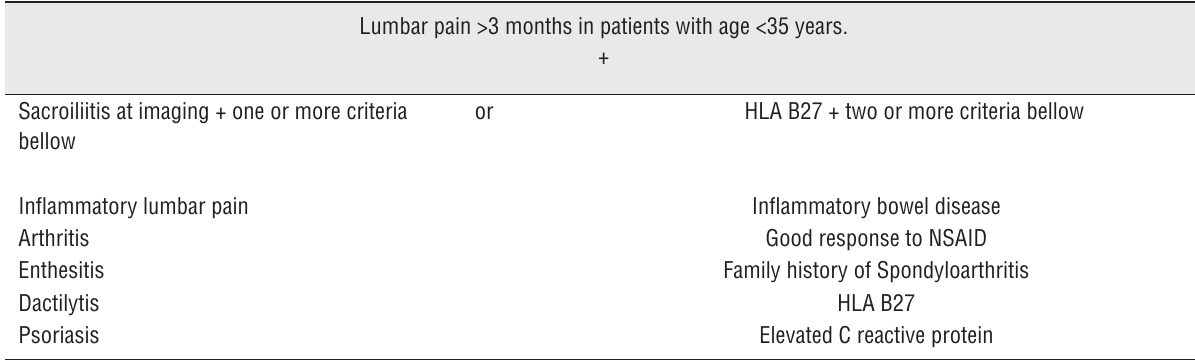
Table 1 - AsAs (Assessment of spondyloArthritis international society) classification criteria for spondyloarthritis (1). Lumbar pain >3 months in patients with age <35